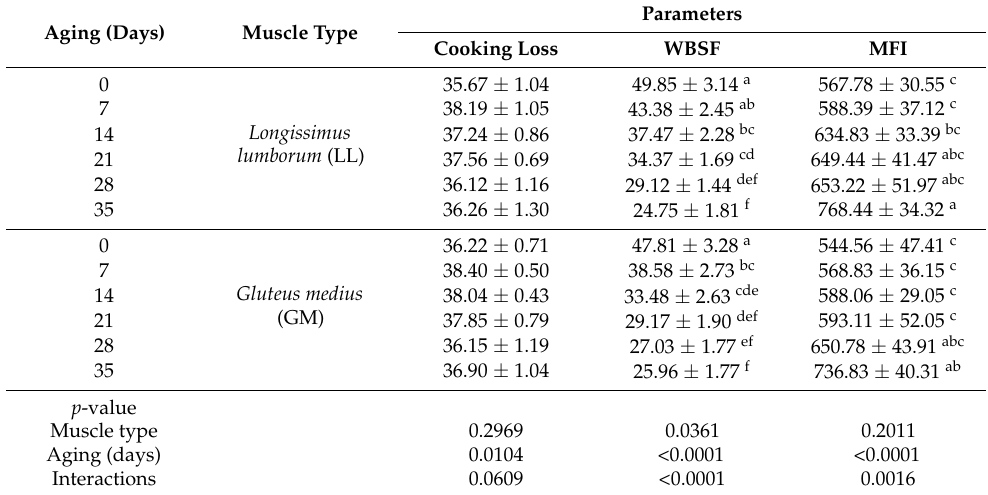
Table 2. Effect of aging time and muscle type on cooking loss, WBSF, and MFI values of buffalo meat. Aging (Days)